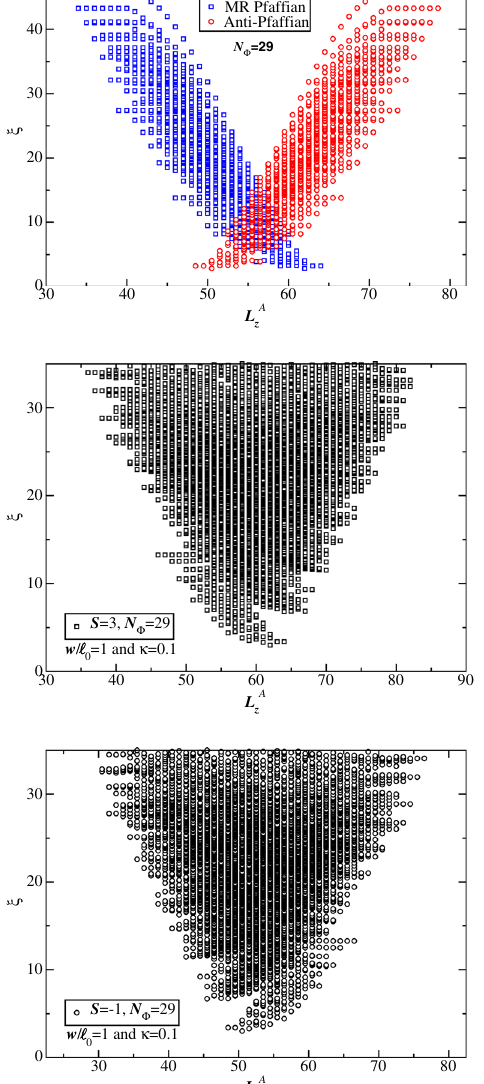
FIG. 6. The entanglement spectra for the MR Pfaffian (blue squares) and aPf (red circles) on the sphere at S ¼ 3 and S ¼ − 1 , respectively, are shown in the top panel. The MR state has a negative slope (discussed more in the text), while the aPf has a positive slope. The middle and lower panels show the entangle- ment spectrum for the exact ground state at S ¼ 3 and S ¼ − 1 , respectively, for κ ¼ 0 . 1 and w= l 0 ¼ 1 . At S ¼ 3 , the low-lying states show the same slope and level structure as the MR state, and at S ¼ − 1 , they show the same slope and level structure as the aPf state. Both systems are at N Φ ¼ 29 and are partitioned to have15orbitals in eachhemisphere. (The partitioningcorresponds to the partition of P ½ 0 j 0 (cid:2) in the notation of Li and Haldane